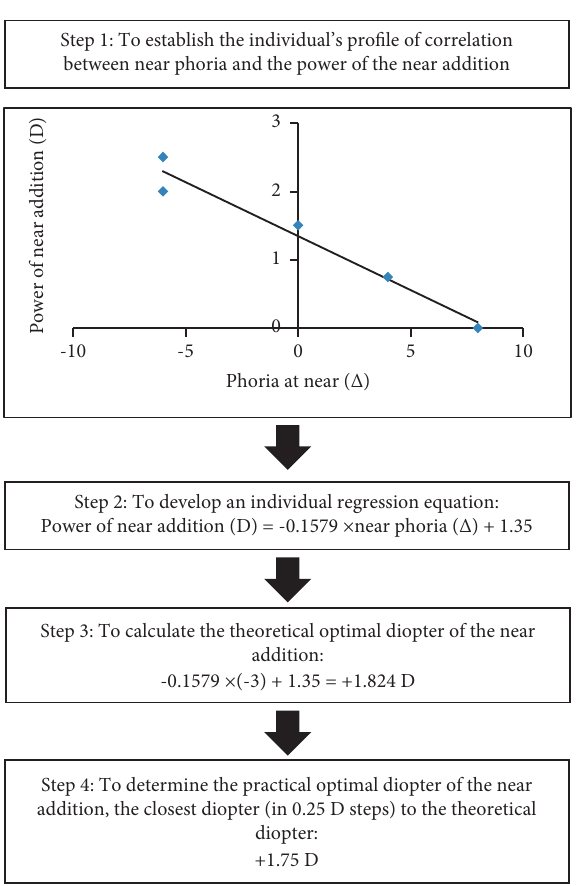
Figure 2: The procedures for determining the optimal near